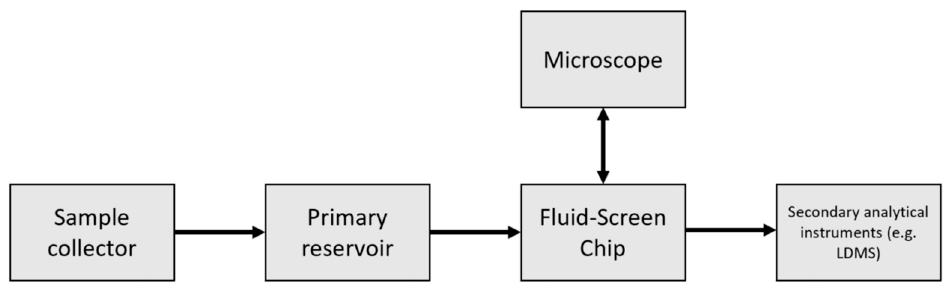
Figure 5. Schematic of the Fluid-Screen in the context of other instruments on the VAIHL mission concept. Liquid cloud droplets are collected by sample collector (e.g., analogous to the “fog harp” instrument [38–41]) into the primary reservoir which then feeds the sample to FS Chip. FS Chip is combined with a microscope for direct visualization of captured biological particles. Upon successful visualization of the sample Fluid-Screen can release the captured particles for analysis in secondary instruments (e.g., LDMS [37]).